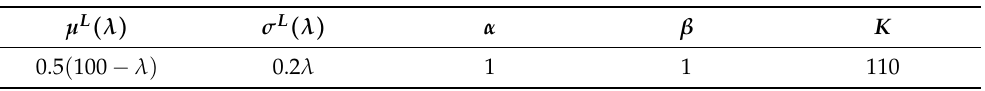
Table 1. Parameters used for the valuation of the stop-loss contract. The claim sizes are Gamma ( α , β ) distributed with density function f α , β